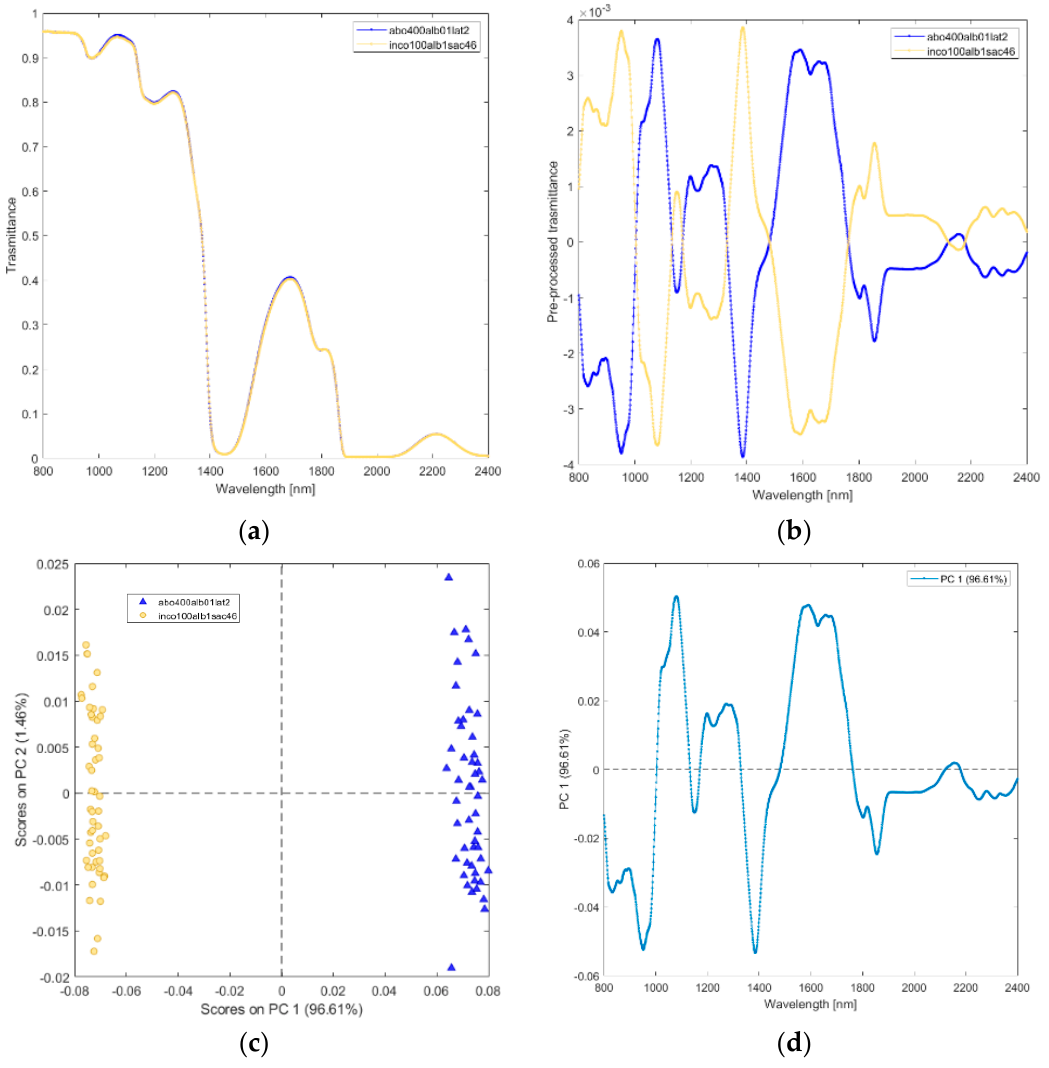
Figure 7. Average raw ( a ) and pre-processed ( b ) transmittance spectra for incobotulinum A toxin (inco100alb1sac46), and equiactive abobotulinum A toxin (abo400alb01lat2). PC1 − PC2 score plot ( c ) and loading plot of PC1 ( d ) for incobotulinum A toxin (inco100alb1sac46), and equiactive Abobotulinum A toxin (abo400alb01lat2).